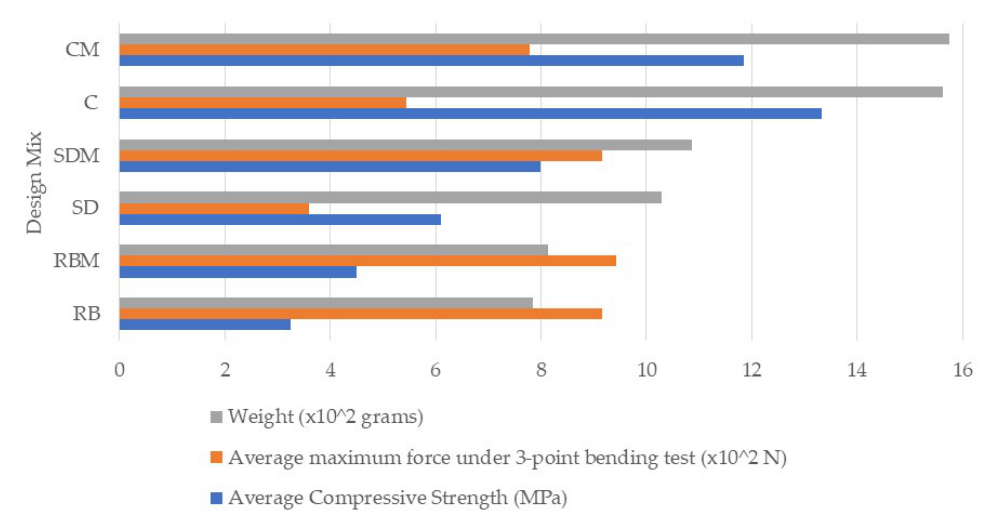
Figure 10. Relationship of mechanical properties and its weight.